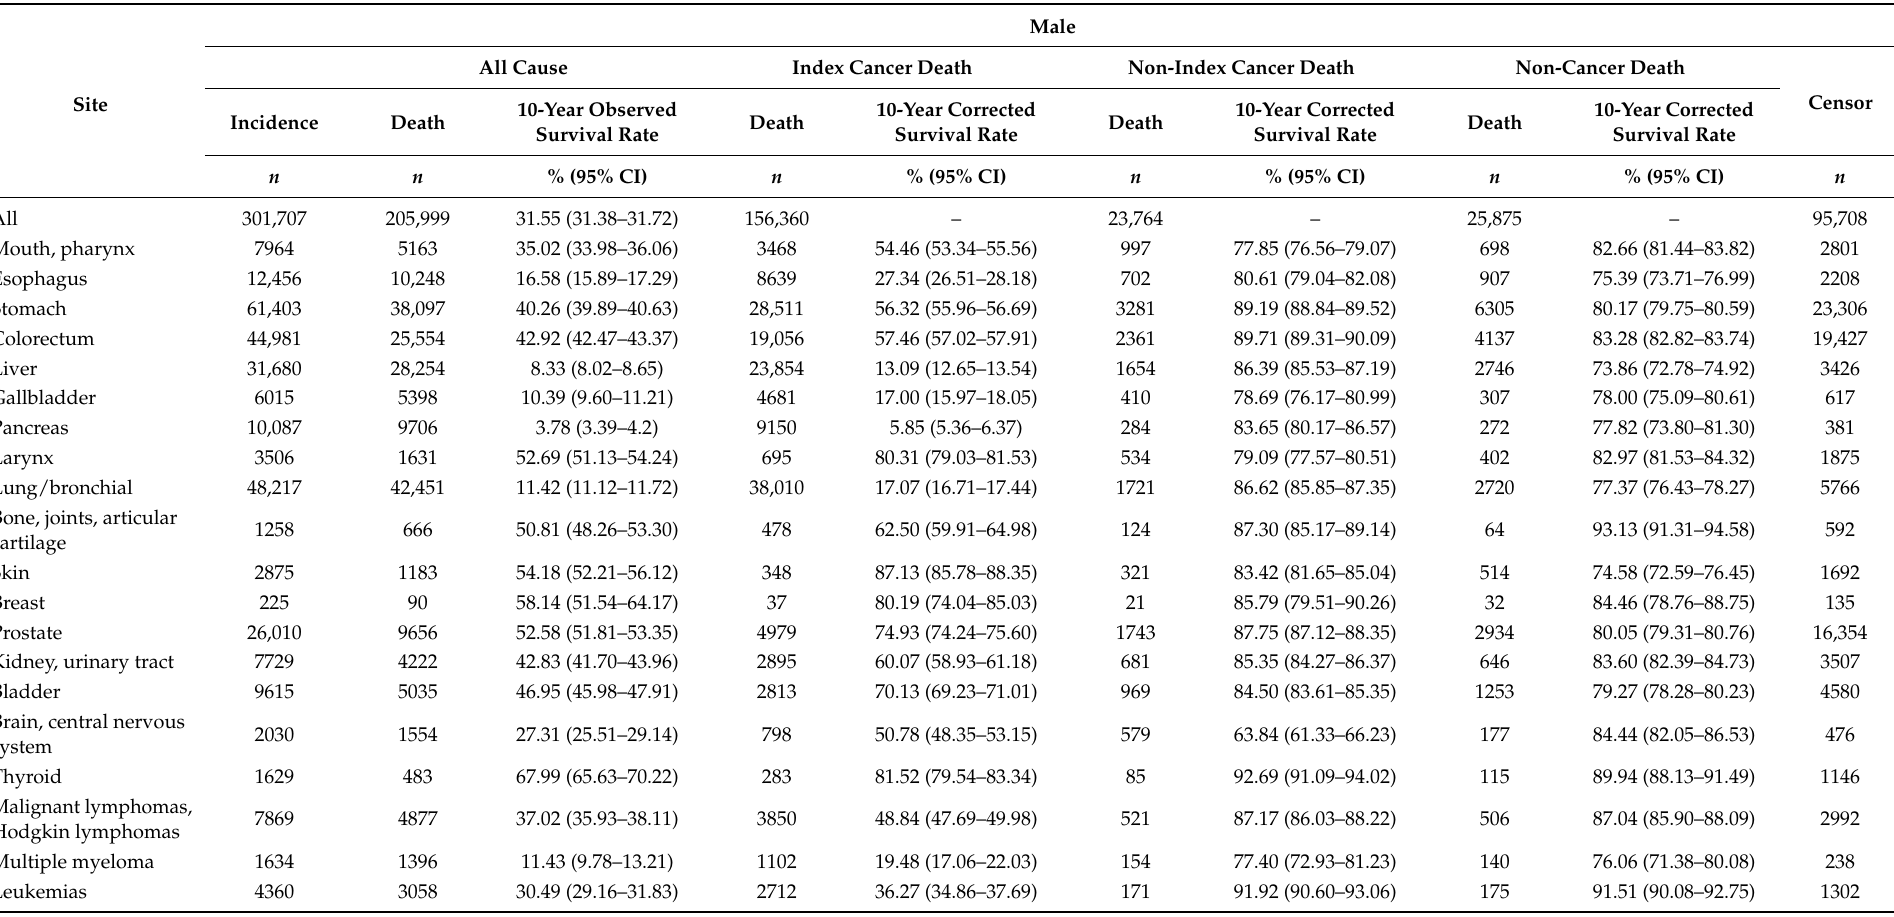
Table 2. Summary of cancer morbidity and 10-year cancer mortality by cause of death (male, incidence: 1995–2011, death or survival: